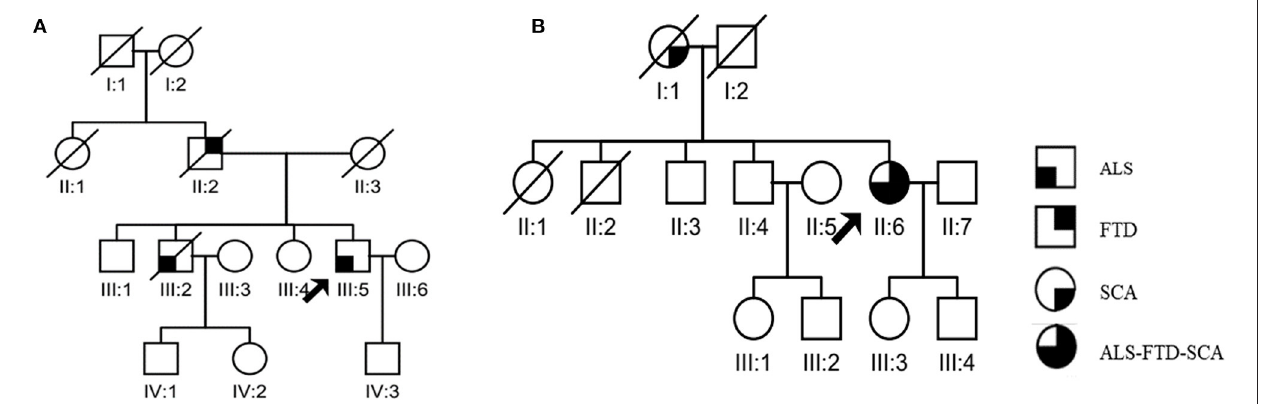
FIGURE 2 | Pedigrees of ALS patients carrying an HREs mutation in C9orf72 (A) and a CAG repeat of length 37 in ATXN2 (B)